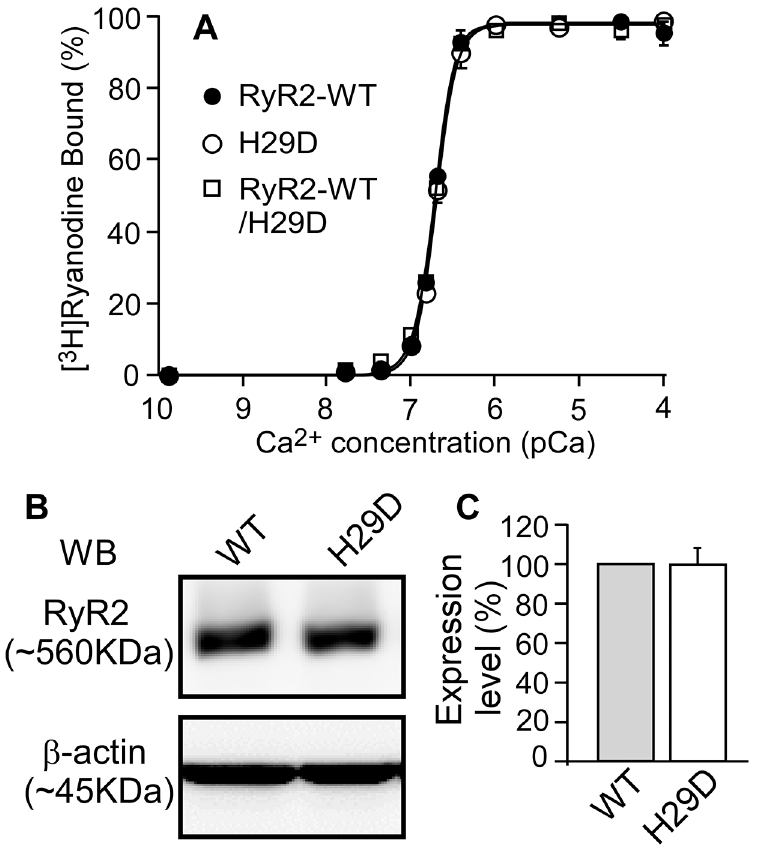
Fig 1. Effect of the H29D mutation on the Ca 2+ dependent activation of [ 3 H]ryanodine binding to RyR2. (A) [ 3 H]ryanodine binding to cell lysate from HEK293 cells expressing the RyR2 WT or the H29D mutant was carried out at various Ca 2+ concentrations (~0.2 nM to 0.1 mM), 100 mM KCl, and 5 nM [ 3 H]ryanodine. Amounts of [ 3 H]ryanodine binding at various Ca 2+ concentrations were normalized to the maximal binding (100%). Data points shown are mean ± SEM from 3 separate experiments. (B,C) Immuno-blotting of RyR2 WT and the H29D mutant from the same amount of cell lysates using the anti-RyR antibody (34c) (n = 3).